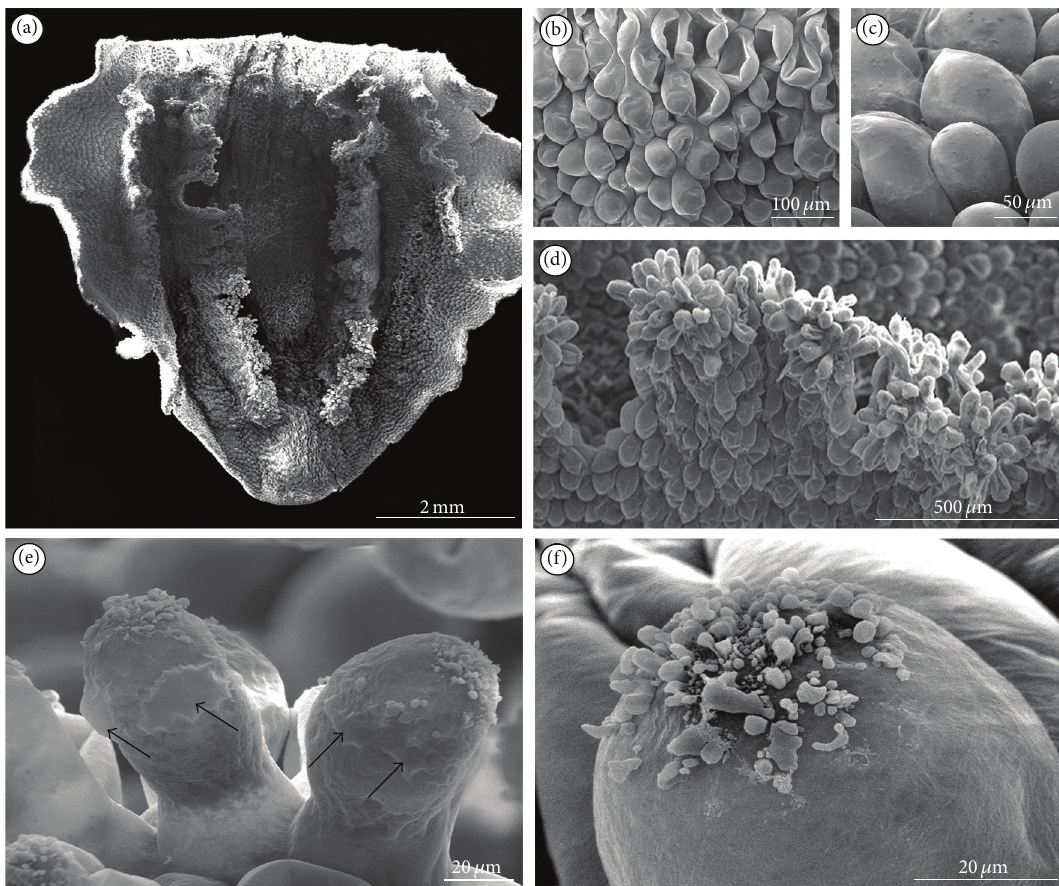
Figure 2: SEM studies of lip on the 8th day of anthesis. (a) Cordate epichile with papillate ridges. (b) Rounded (often sunken) cells from the furrow. (c) Rounded cells close to margin without secretions. (d) Papillate ridges with multicellular outgrowths. (e) Papillae with the cuticle swellings ( arrows ) at their backsides and secretion at their apices. (f) Secretion at the apex of